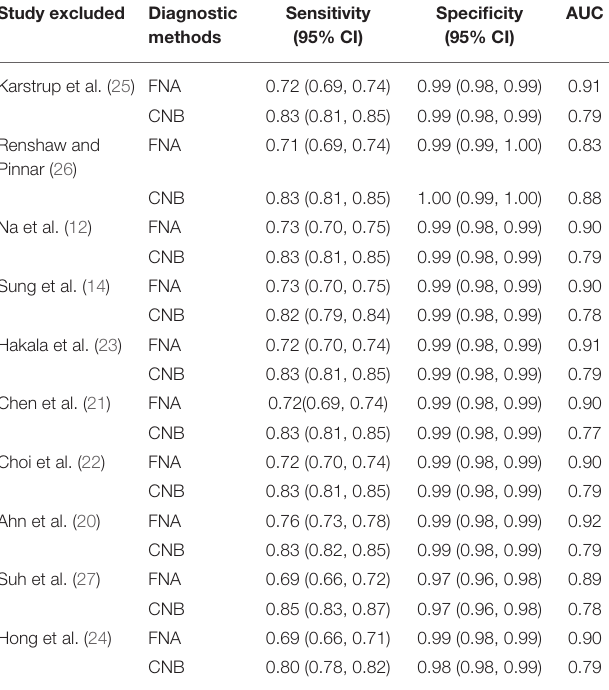
TABLE 3 | The influence of individual studies using the leave-one-out